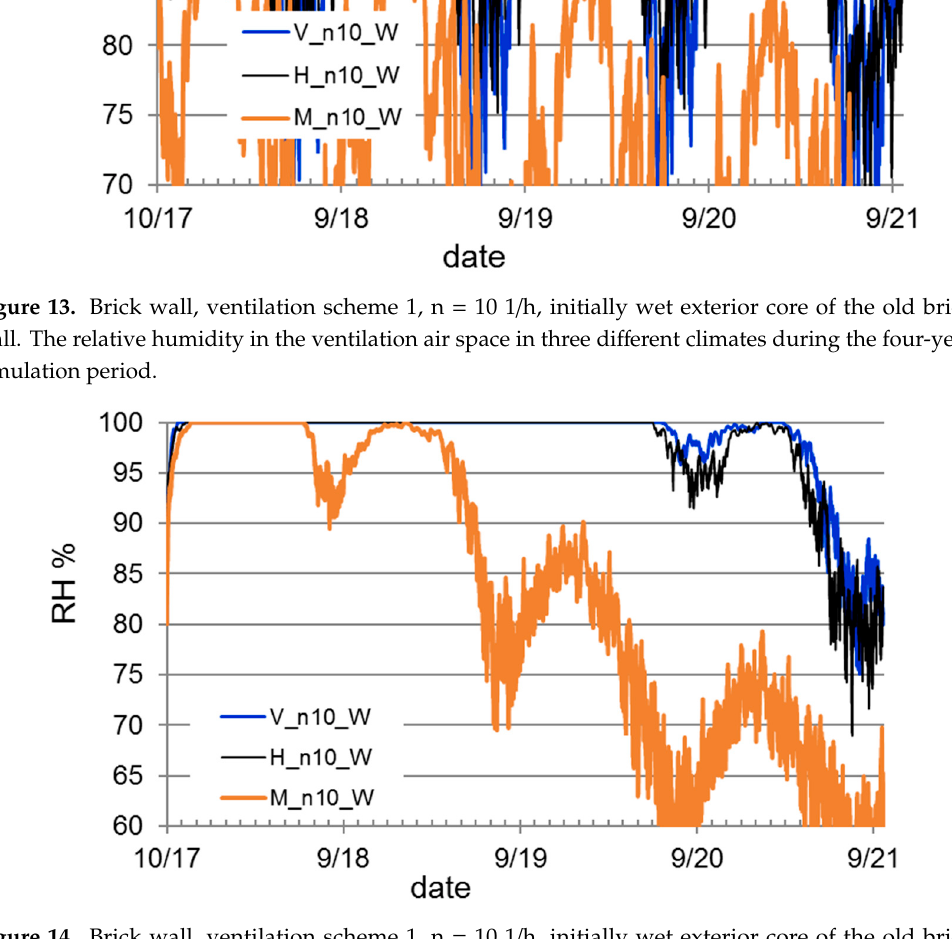
Figure 14. Brick wall, ventilation scheme 1, n = 10 1/h, initially wet exterior core of the old brick wall. The relative humidity in the boundary between mineral wool back layer insulation and the PU-insulation of the panel in three different climates during the four-year simulation period.